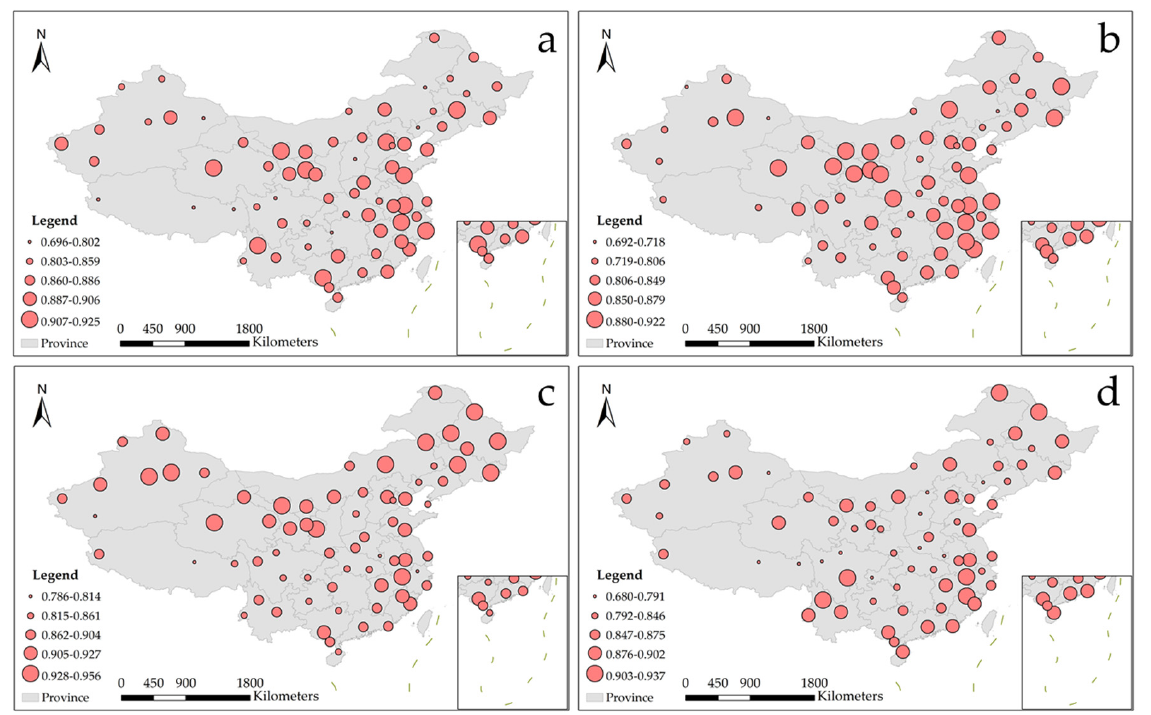
Figure 11. Regional distribution of R 2 for the 72 stations using the Sen Model in spring ( a ), summer ( b ), autumn ( c ) and winter ( d ).